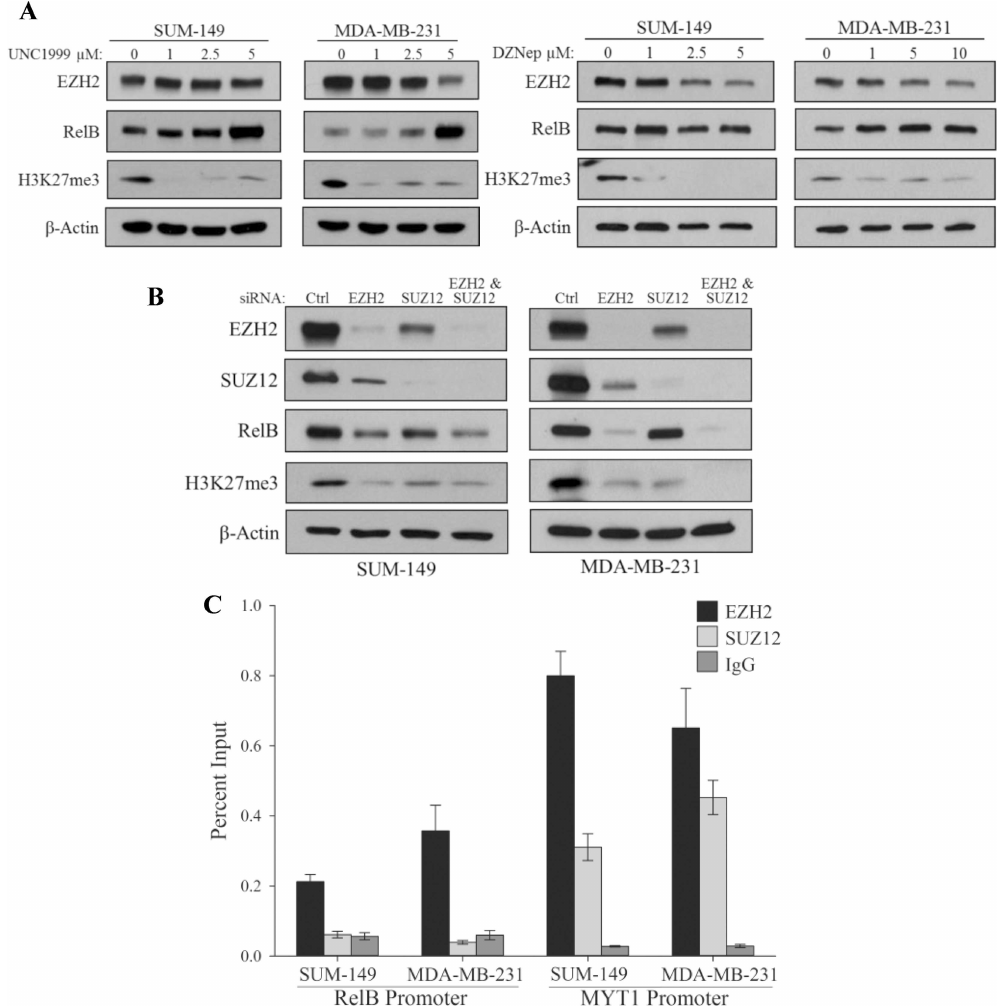
Fig 4. The HMT activity of EZH2 is not Required for RelB Transcription. (A) Immunoblots of indicatedproteins in SUM-149 or MDA-MB-231 cells treated with the indicated concentrations of UNC1999(left panel) or DZNep (right panel) for 72 hours. β -actin serves as a loadingcontrol. (B) Immunoblots of indicatedproteins in SUM-149 or MDA-MB-231 cells expressing control siRNA or siRNA targeting EZH2, SUZ12 or both EZH2 and SUZ12. β -actin serves as a loadingcontrol. (C) ChIP analysis of EZH2 and SUZ12 bindingat the RelB promoter or the MYT1 Promoter as a positive control in SUM-149 and MDA-MB-231 cells. Non-specific bindingwas estimated from IgG immunoprecipitates. Values given as means ± standard deviationfrom three technicalrepeats of one representative experimentfrom the three